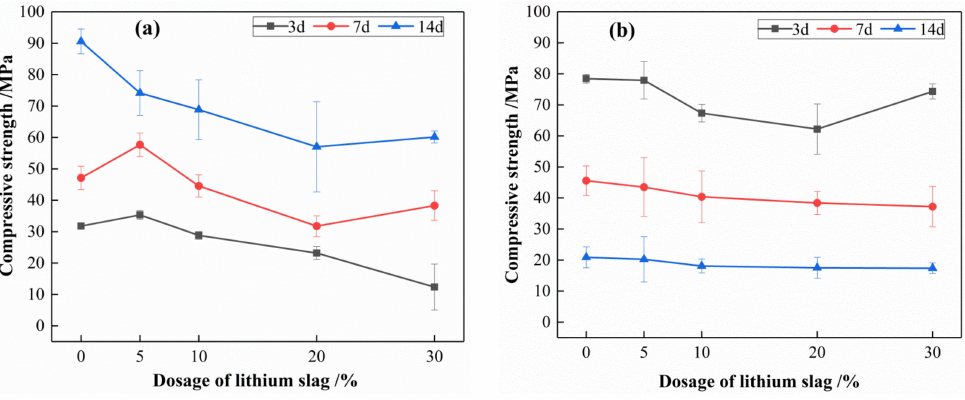
Figure 3. The compressive strength of MOC in air ( a ) and water ( b